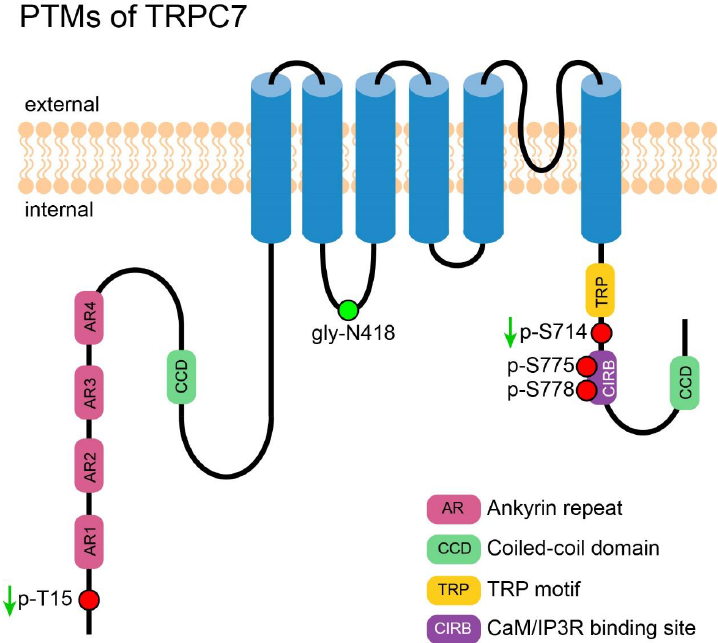
Figure 6. PTMs of TRPC7. A cartoon depicting TRPC7 with its important motifs and PTMs (those exact positions had been reported). PTMs are presented in circles. Red circles represent the reported phosphorylation sites of TRPC7, which are labeled in the format of a “p-amino acid-position”. The green circle represents the reported N-glycosylation site, which is labeled in the format of a “gly-amino acid-position”. The green arrows near the labels denote the PTMs decrease the channel’s activity. Table 1. PTMs of different members of TRPC as reported by traditional experimental studies.